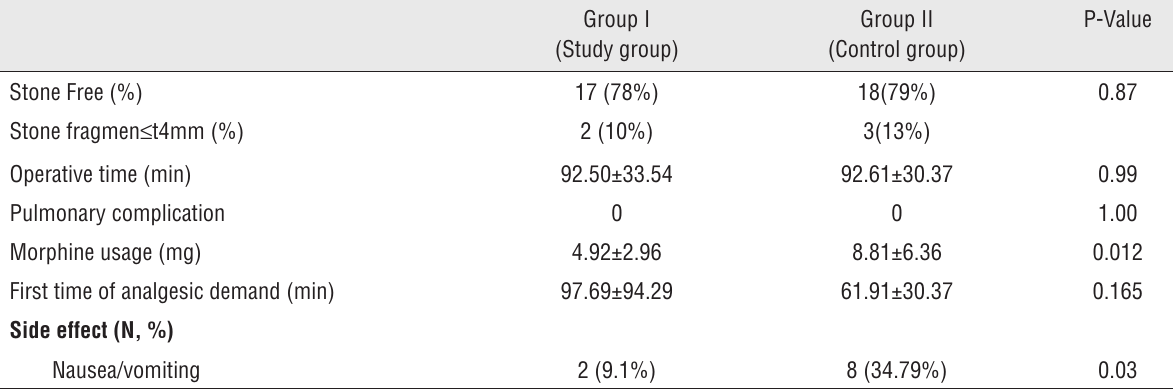
Table 4 - clinical outcomes and complications (supracostal access